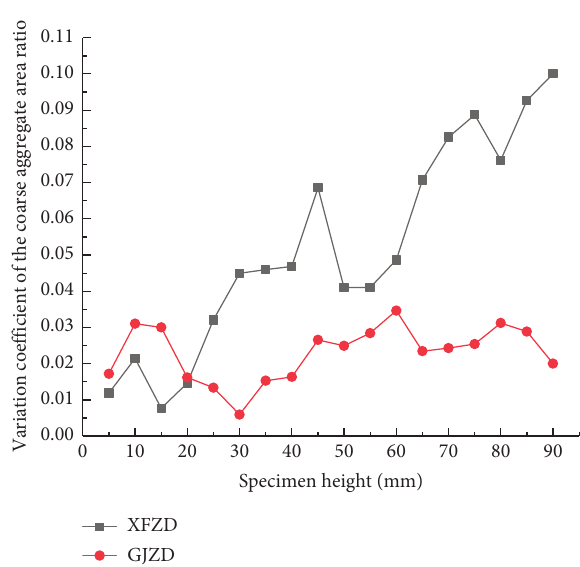
Figure 11: The void distribution characteristics of different gra- dation under static compaction.